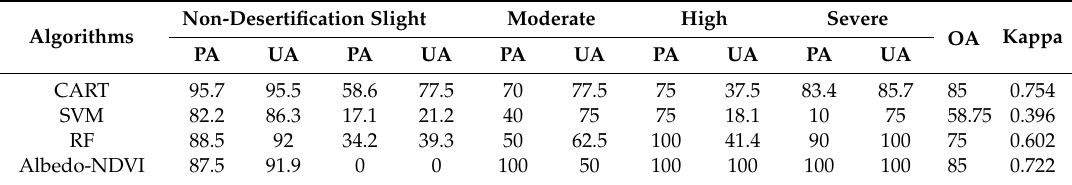
Table 6. Accuracy comparison of the four methods (OA, PA, and UA: